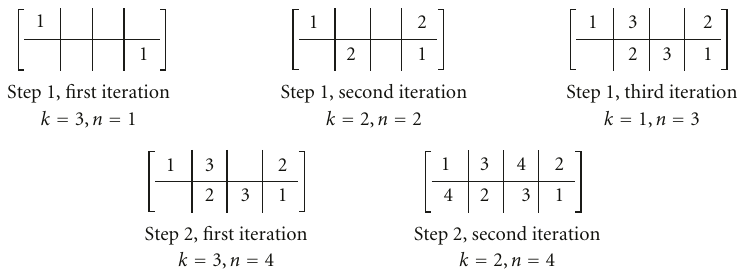
Figure 13: A possible sequence of code matrices obtained at various stages of the algorithm ( M = 2 and Q = 4).